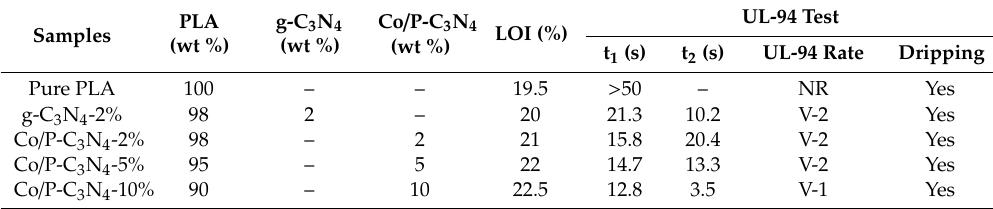
Table 1. Formulations, LOI and UL-94 test results of PLA composites.